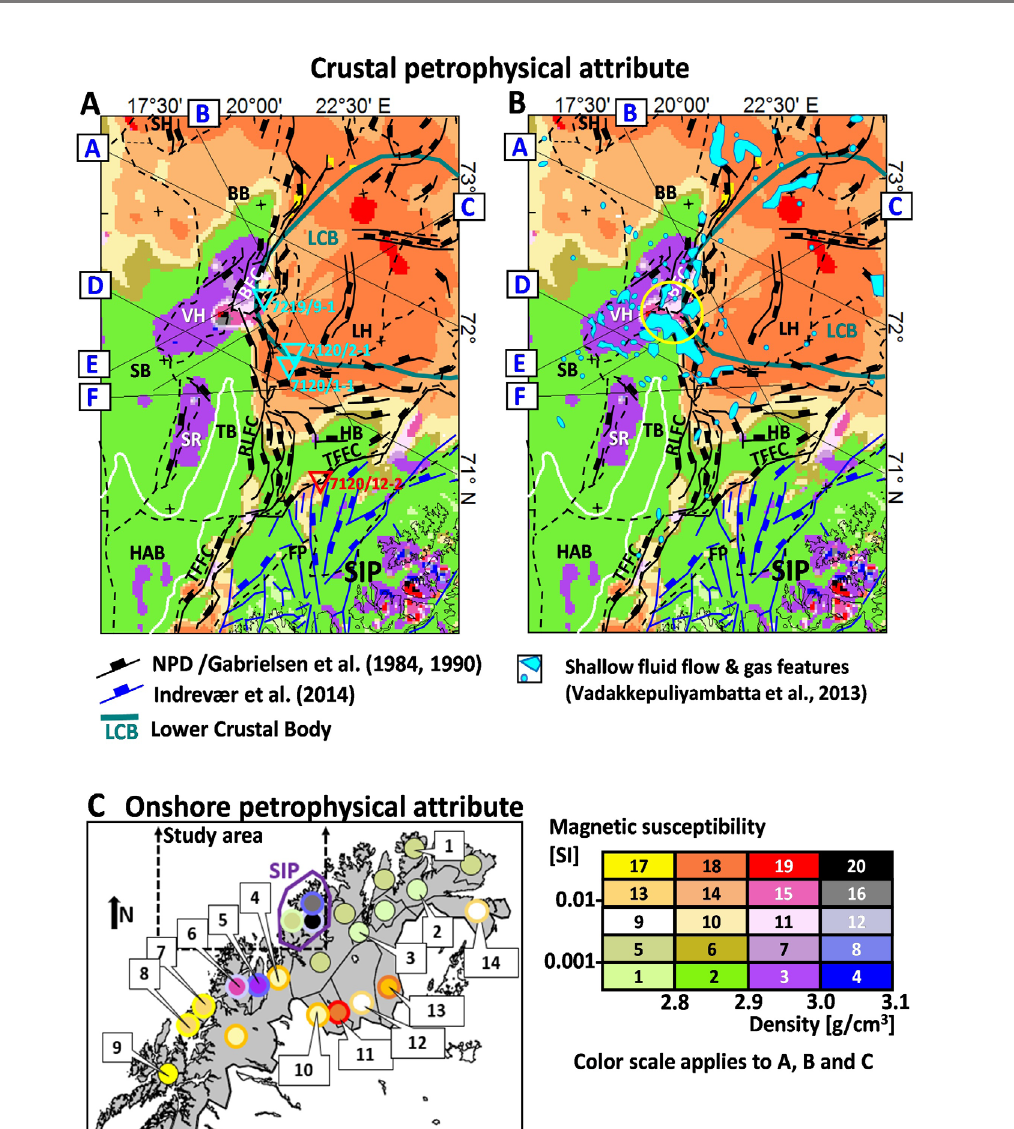
Figure 13. (A) Crustal petrophysical attribute with offshore faults (black lines; Norwegian Petroleum Directorate: www.factmaps.npd.no/factmaps/3_0/ visited 11.01.2022, based on Gabrielsen et al., 1984; 1990), near-shore and onshore faults (blue lines; Indrevær et al., 2014), and well locations penetrating the crystalline basement (red and blue triangles). (B) Crustal petrophysical attribute with areas of shallow fluid flow and gas features (Vadakkepuliyambatta et al., 2013), yellow ring marks area where methane flux may be linked with serpentinisation. BFC – Bjørnøyrenna Fault Complex, RLFC – Ringvassøy–Loppa Fault Complex, TFFC – Troms–Finnmark Fault Complex; boundaries of structural elements (black dashed, details in Fig. 1, abbreviations in Fig. 2), seismic profiles (black lines, details in Fig. 1), contour line (white) of crustal susceptibility “-0.0175 SI”. (C) “Onshore petrophysical attribute” map presenting averages of densities and magnetic susceptibilities of onshore rocks (Olesen et al., 2010; Table 3): each circle indicates by its colour fill which petrophysical attribute is valid for the geographic area enclosed by black border lines or by coastline, a circle bounded by colour other than black indicates the range encompassed by the onshore petrophysical attributes of both